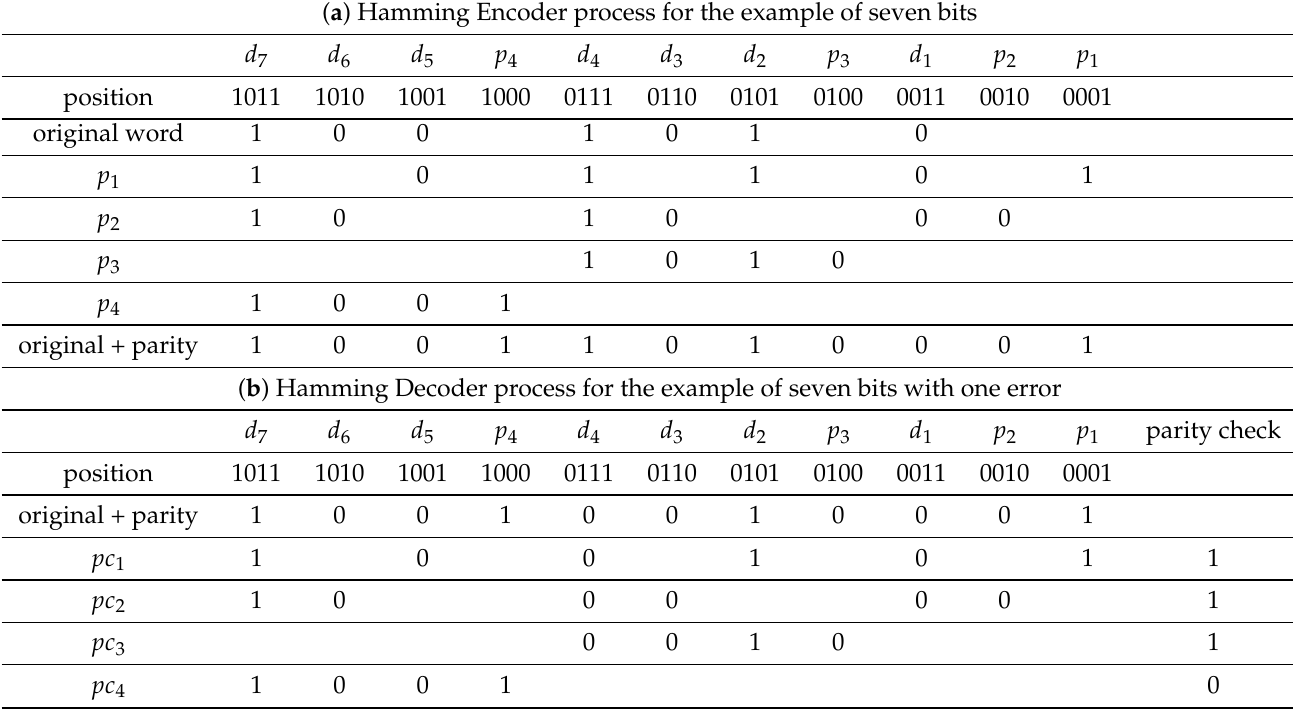
Table 5. Hamming Encoder and Decoder processes for error detection and correction in the example of seven